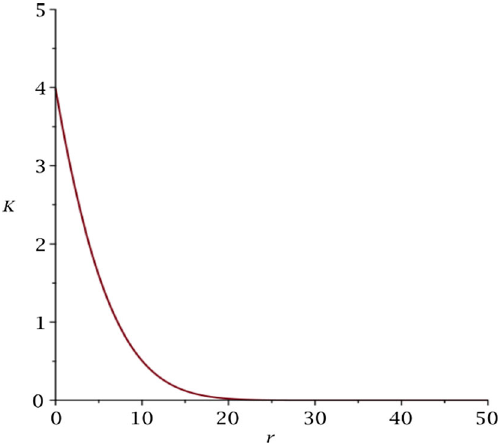
Fig. 1 Behavior of the Kretschmann scalar along the radial distance when a = − 10 − 3 . It shows clearly the absence of singularity in the spacetime we are considering when a suitable choice of the integration constants are made ation, resulting in a far from trivial problem. However, this is a different approach which is beyond the scope of this